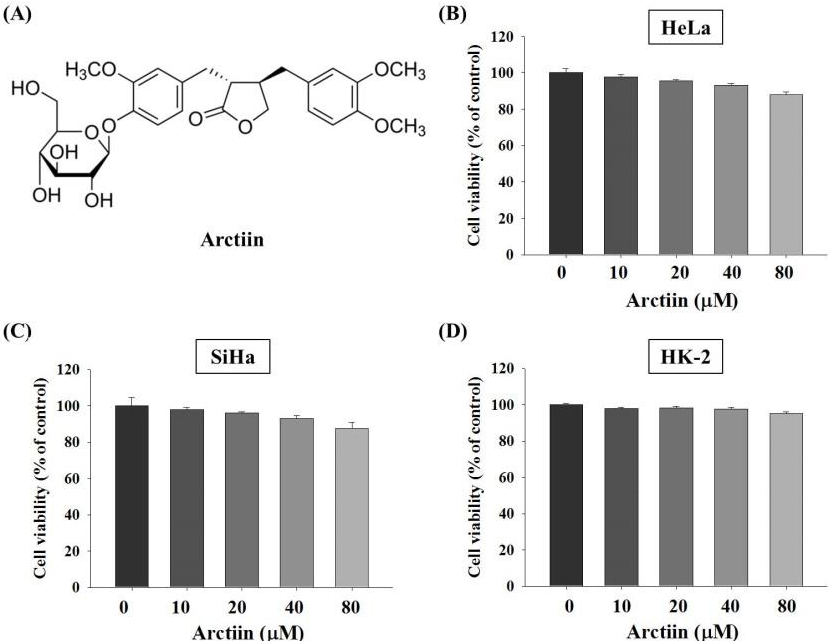
Figure 1. Effects of arctiin on the cell viability of HeLa, SiHa and human proximal tubular HK-2 cells. ( A ) Chemical structure of arctiin. ( B ) HeLa, ( C ) SiHa and ( D ) HK-2 cells were treated with various concentrations (0, 10, 20, 40 and 80 μM) of arctiin for 24 h before being subjected to an MTT assay for cell viability. The values represented the means ± SD of at least 3 independent experiments.